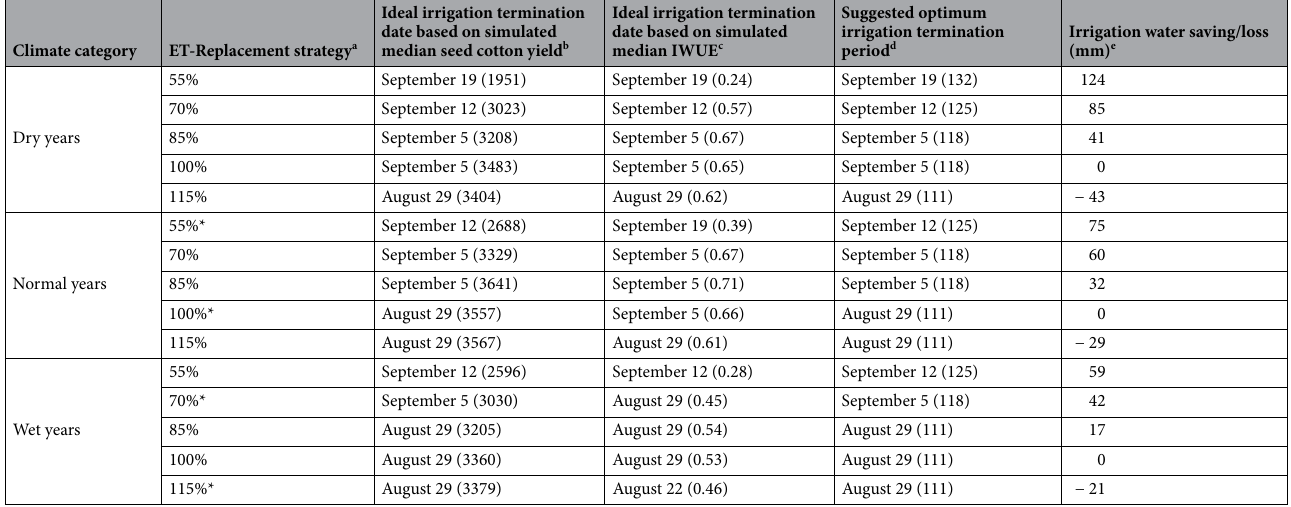
Table 3. Suggested optimum timings of irrigation termination for excess/deficit irrigation treatments in dry, normal and wet years. a Strategies indicated by a star symbol had differences in ideal termination periods identified based on median seed cotton yield and IWUE. b Values in parentheses are median seed cotton yields in kg ha -1 . c Values in parentheses are median IWUEs in kg m -3 . d Values in parentheses are days after